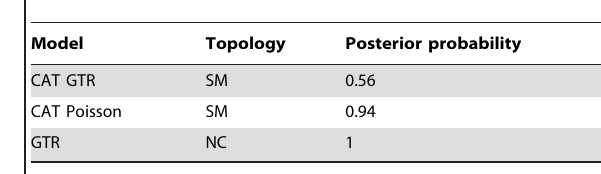
Figure S1 Phylogenetic analyses based on the nucleo- tide sequences of the mitochondrial genes encoding proteins with the exclusion of the 3 rd codon position.